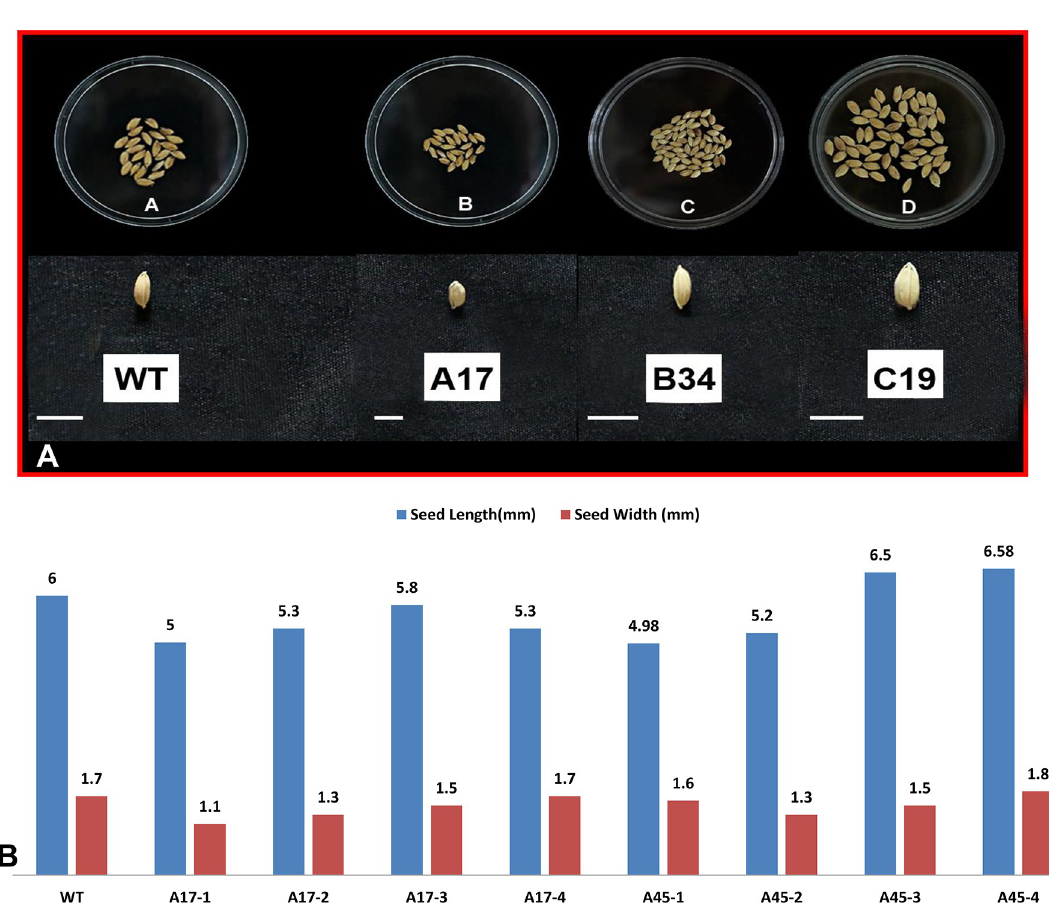
Fig 10. Morphological appearance and comparison of seed size of T1 transgenic progeny plants harboring gene constructs A , B and C and that of wild type (WT). Bar size is in mm. (A) morphological appearance of T1 seeds. Bar size depicting seed length for WT-6.75mm, Construct A-5.5mm, Construct B-7.02mm and Construct C-7.43mm. (B) Seed length and width of WT and various lines derived from construct A, B and C are shown graphically.